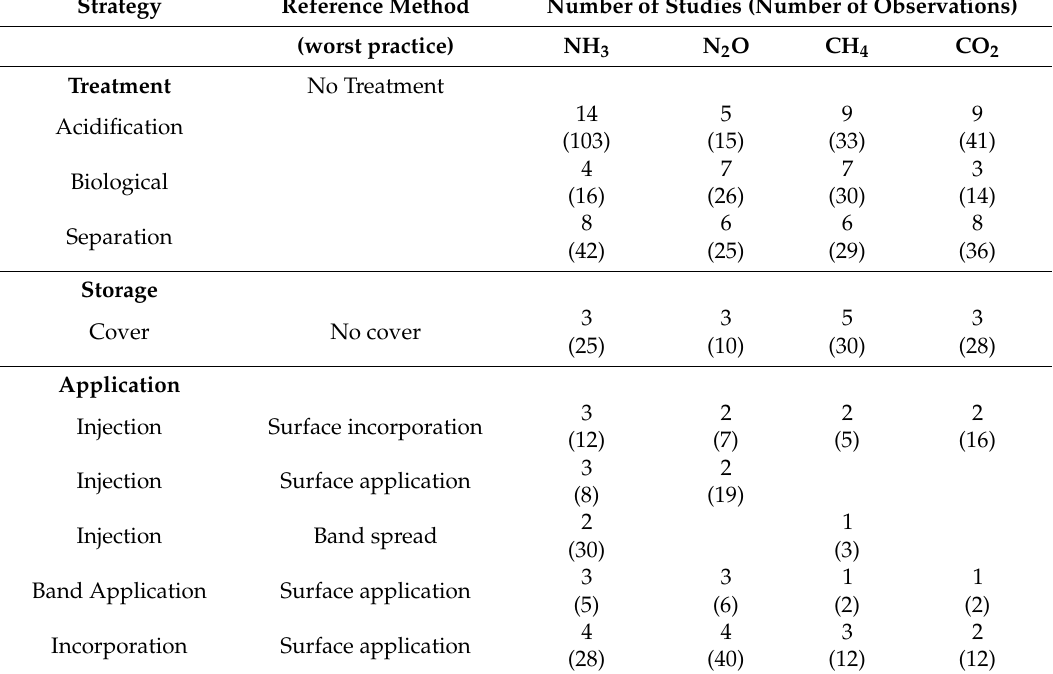
Table 1. Number of selected publications and number of observations per management strategy included in the meta-analysis. The numbers in brackets represent the total number of observations from all studies.